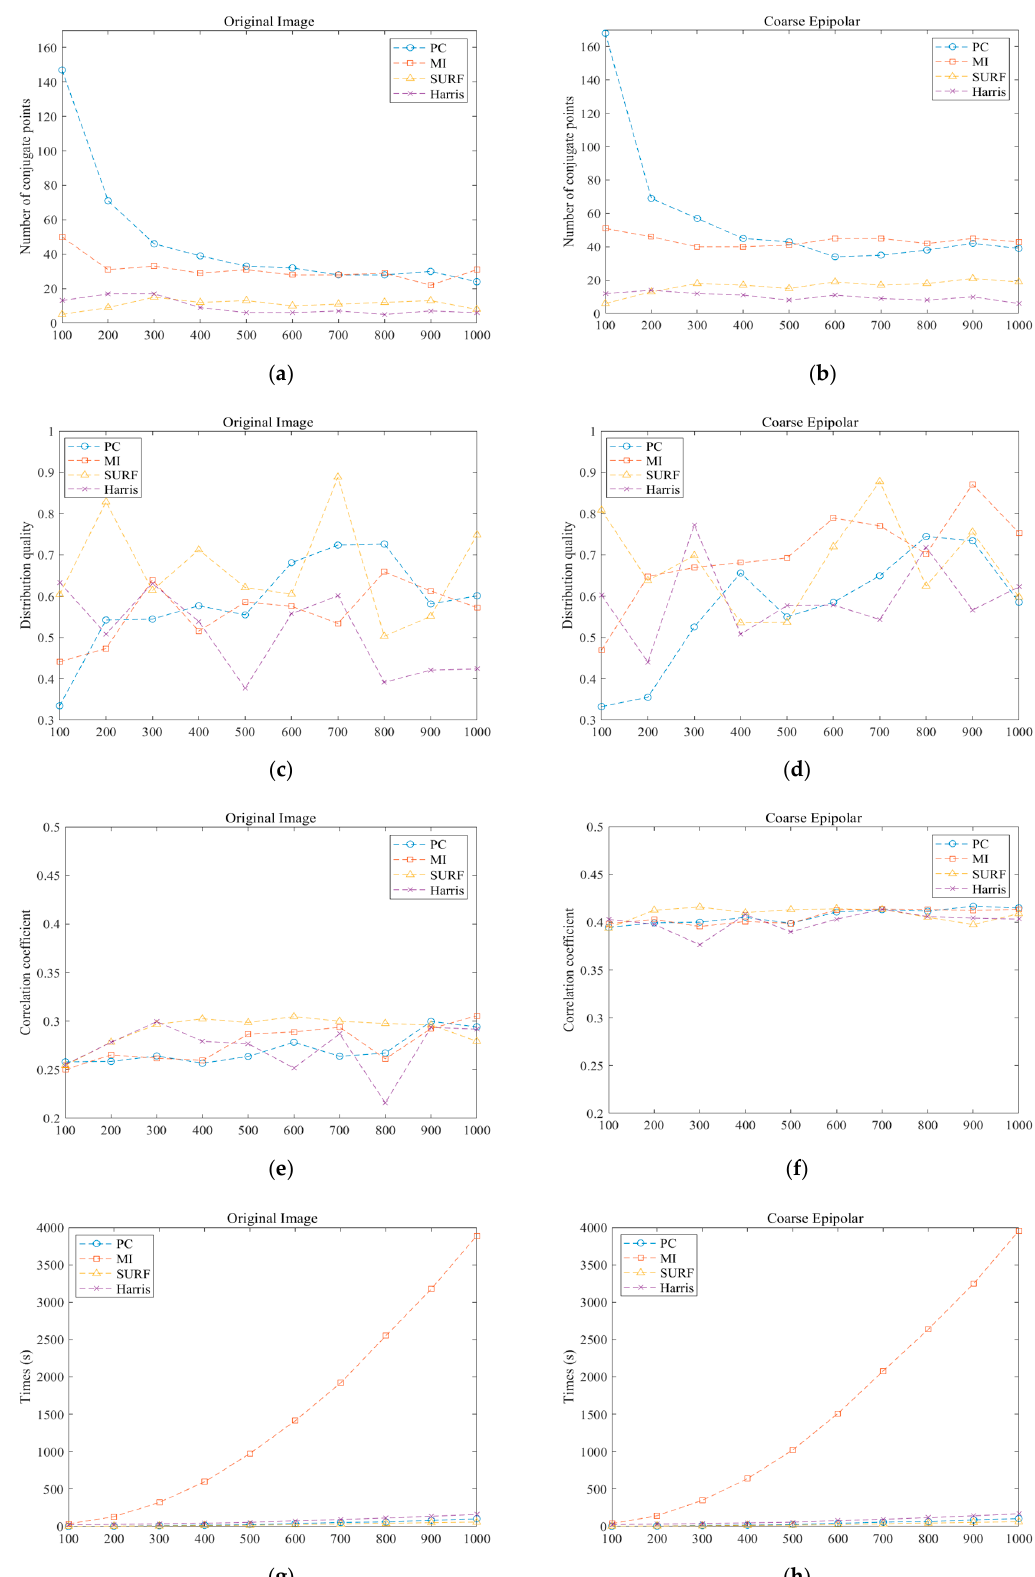
Figure 8. Results of conjugate point extraction (along-track Kompsat-3 stereo data): ( a , b ) number of conjugate points, ( c , d ) distribution quality, ( e , f ) correlation coefficient ( g , h ) process times in original and coarse epipolar images, respectively.